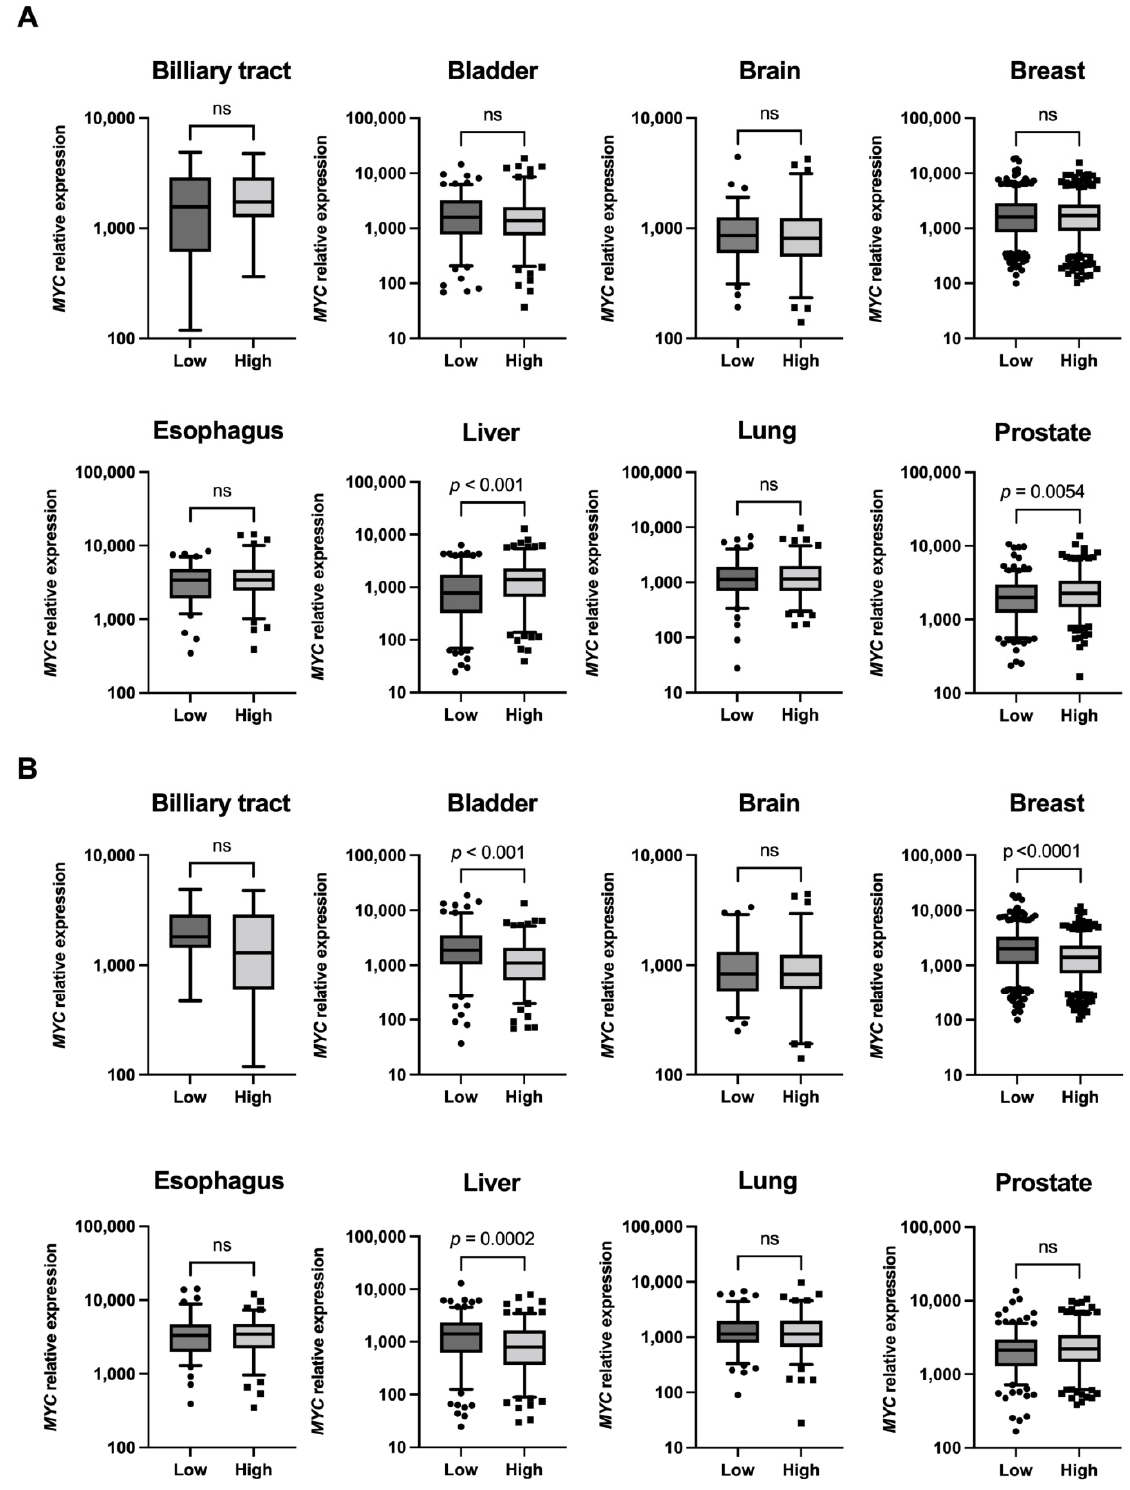
Figure 3. MYC mRNA expression was higher in the groups of tumors with high INTS14 mRNA expression. ( A ) The cases were divided into two groups, low and high, based on the median INTS14 mRNA expression level. The Mann–Whitney U test was performed for each MYC mRNA expression level. ( B ) ERI2 and MYC mRNA were compared, as in ( A ). Not significant (ns).